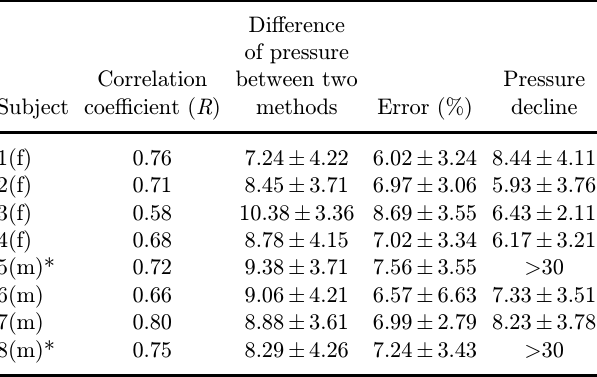
Table 2. The correlation coe±cient between SBP and PTT with error calculation in hemodialysis group. In * subjects, di®erence of pressure and error percentage between cu® method and PTT were calculated just before occurrence of hypotension (f: female and m: